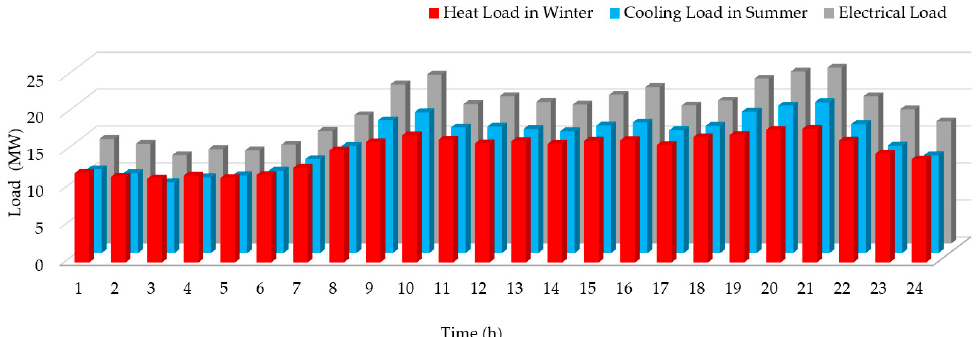
Figure 8. Three types of load in a typical day.